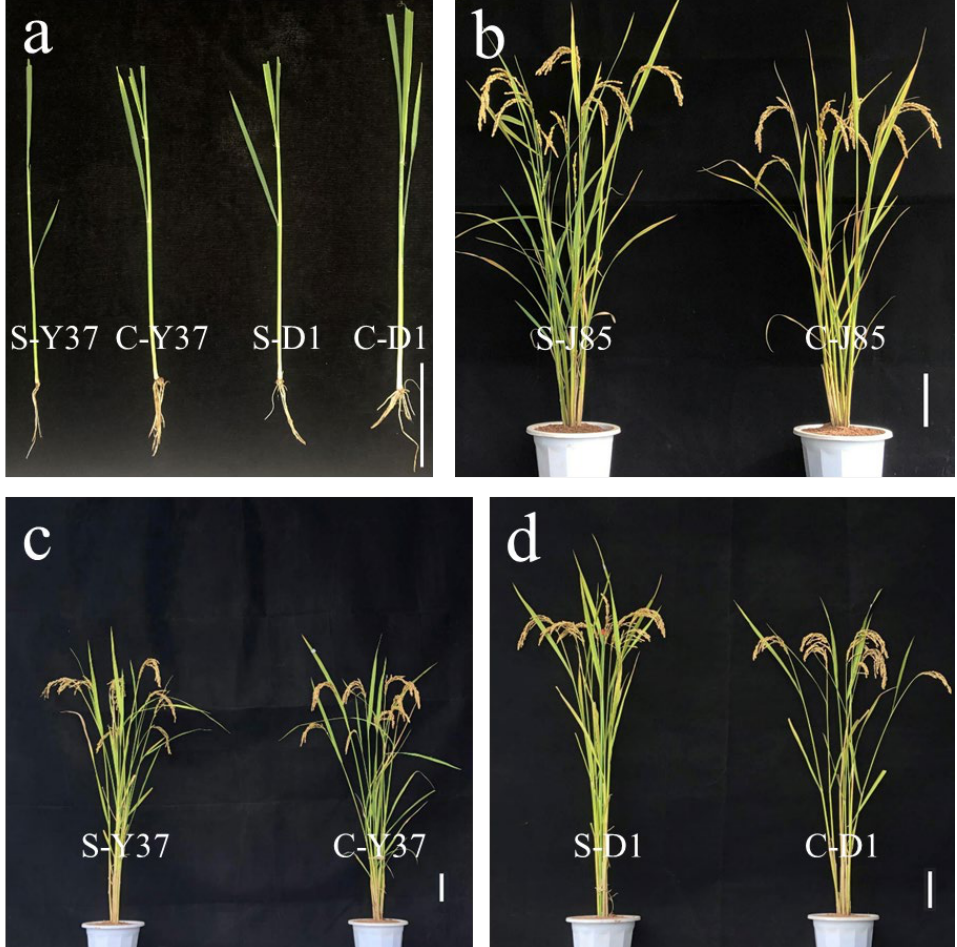
Figure 5. Investigating plant architecture of seed seedling and cutting of ILs/NILs at the seedling and mature period. ( a ) S-Y37 and S-D1 are seed seedlings, C-Y37 and C-D1 are cuttings from the stem branches (bar = 5 cm). ( b – d ) S-J85 and C-J85, S-Y37 and C-Y37, S-D1 and C-D1 are at mature period; (bar = 10 cm).